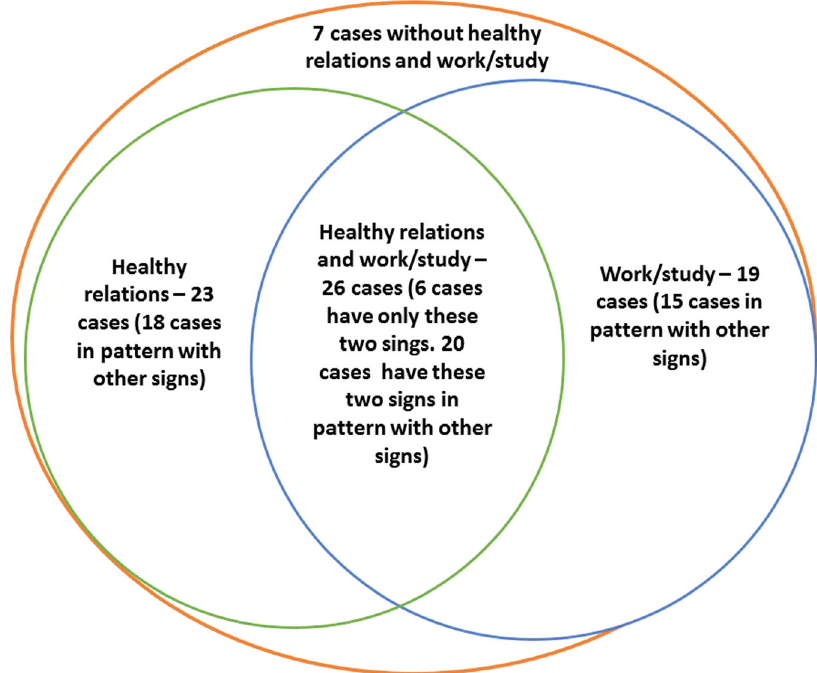
Fig. 1 Venn diagram visualizing the outcomes of the truth table analysis containing healthy relations and work/study as conditions and recovery as an outcome. A green circle shows the number of cases with healthy relations (healthyrel). A blue circle shows the number of cases with work/study. The intersection of the green and blue circles shows the number of cases with both healthy relations and work/study. An orange circle shows the number of cases with neither healthy relations and work/study. Table 5 Outcomes of the subset/superset